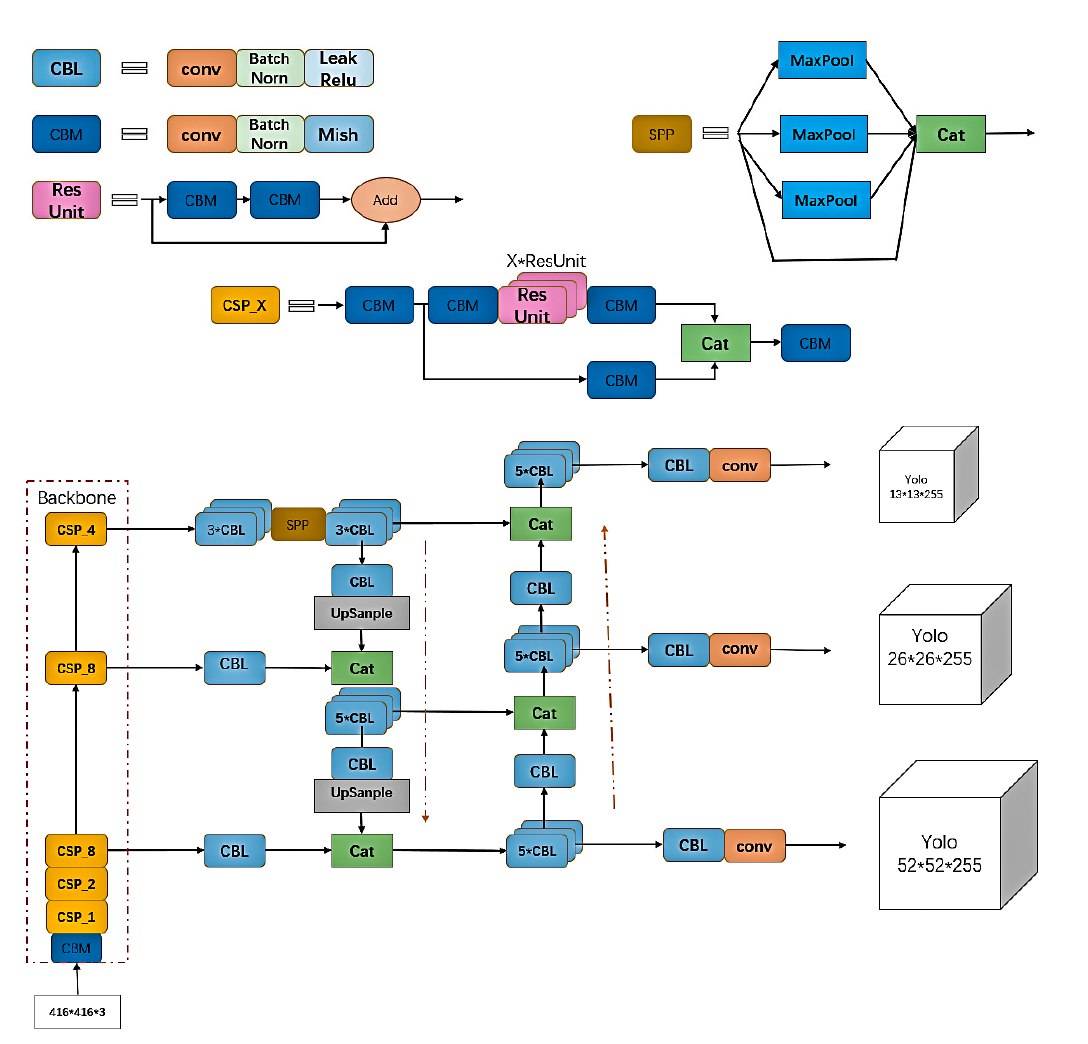
Figure 2. YOLOv4